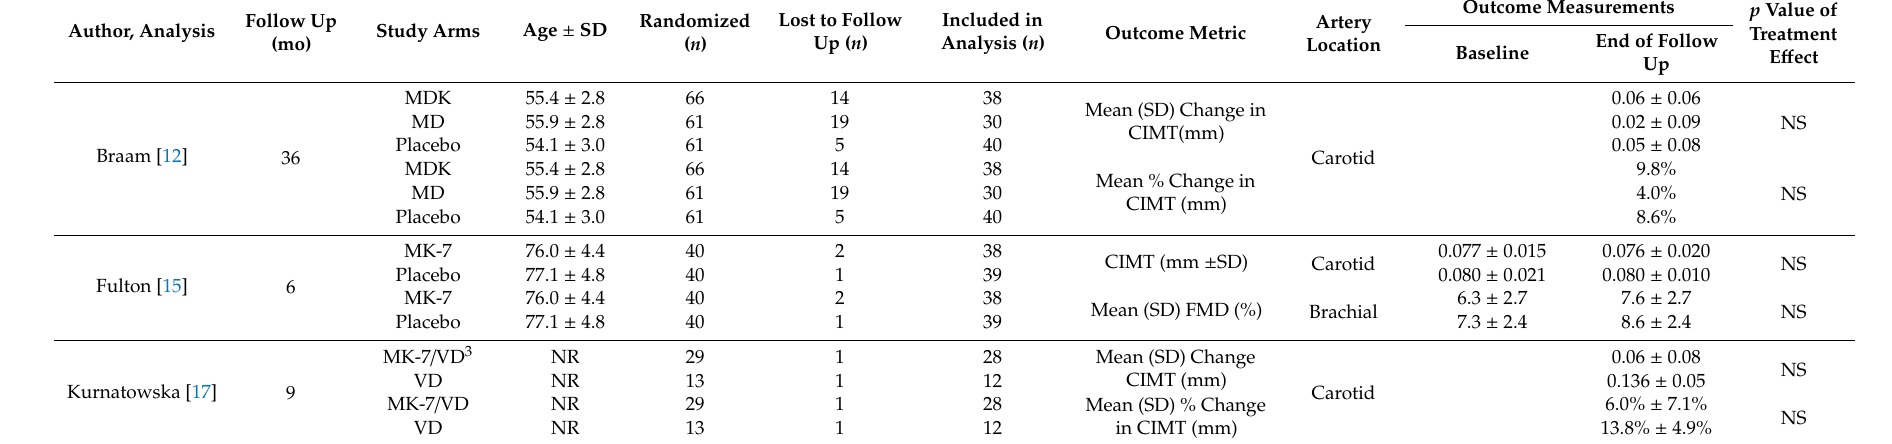
Table 5. E ff ect of vitamin K supplementation on measures of atherosclerosis.